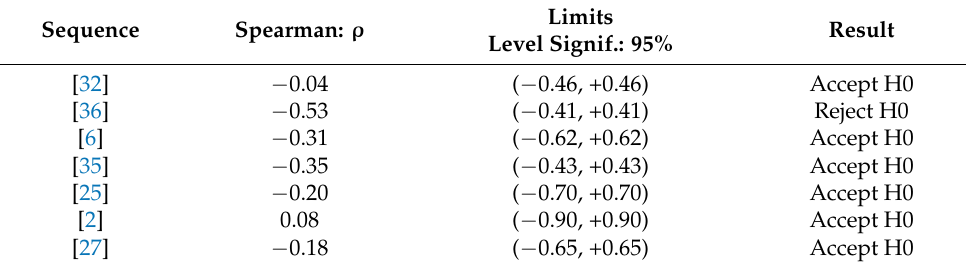
Table 4. Spearman contrast: results.